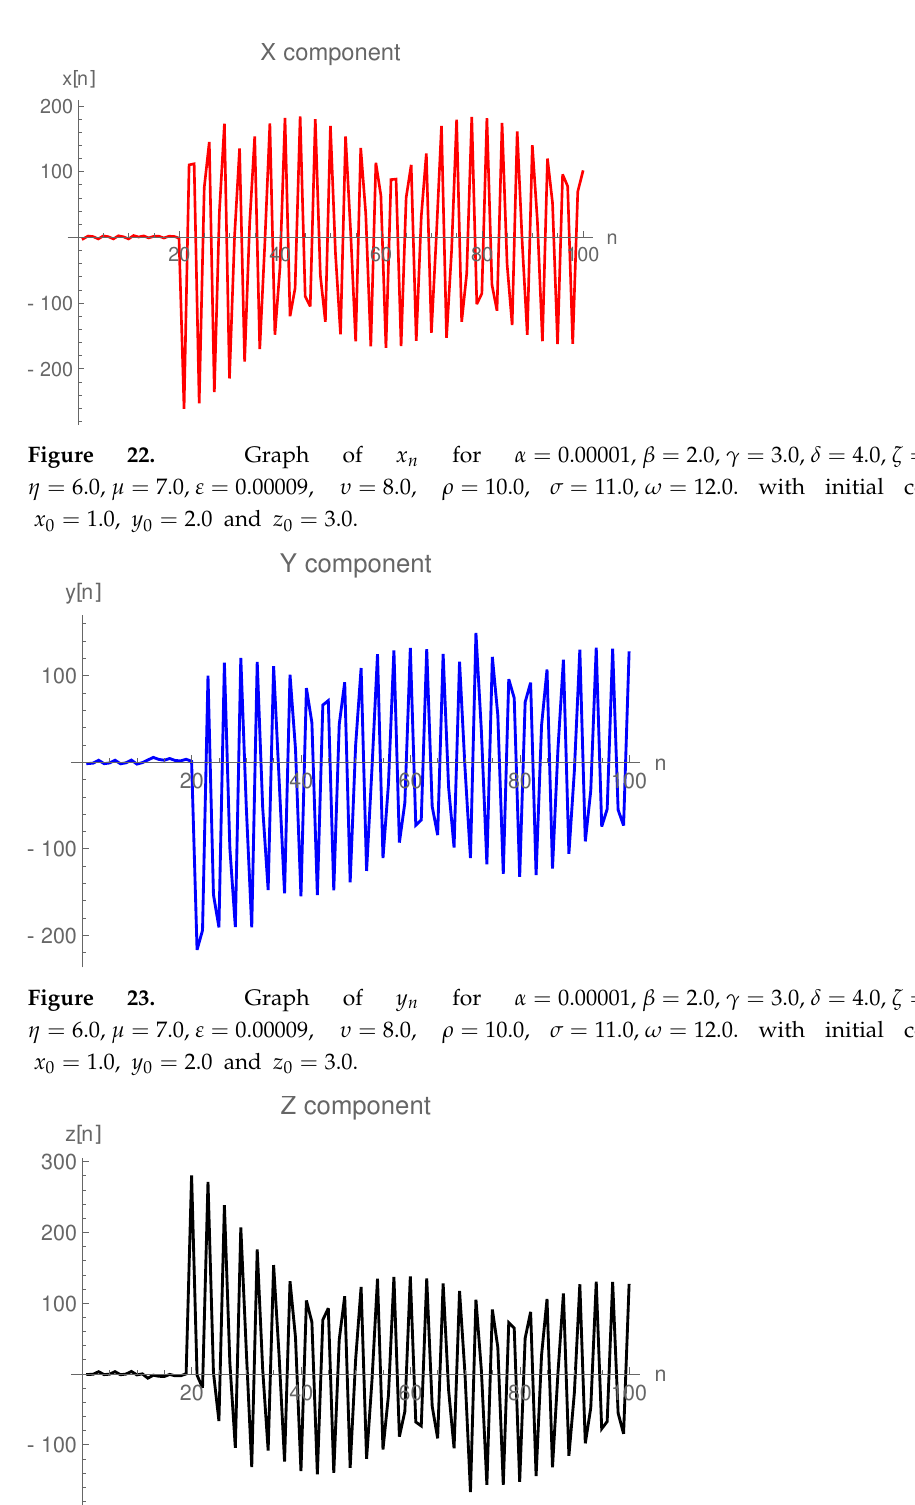
Figure 24. Graph of z n for α = 0.00001, β = 2.0, γ = 3.0, δ = 4.0, ζ = 0.00005, η = 6.0, µ = 7.0, ε = 0.00009, υ = 8.0, ρ = 10.0, σ = 11.0, ω = 12.0. with initial conditions x 0 = 1.0, y 0 = 2.0 and z 0 =